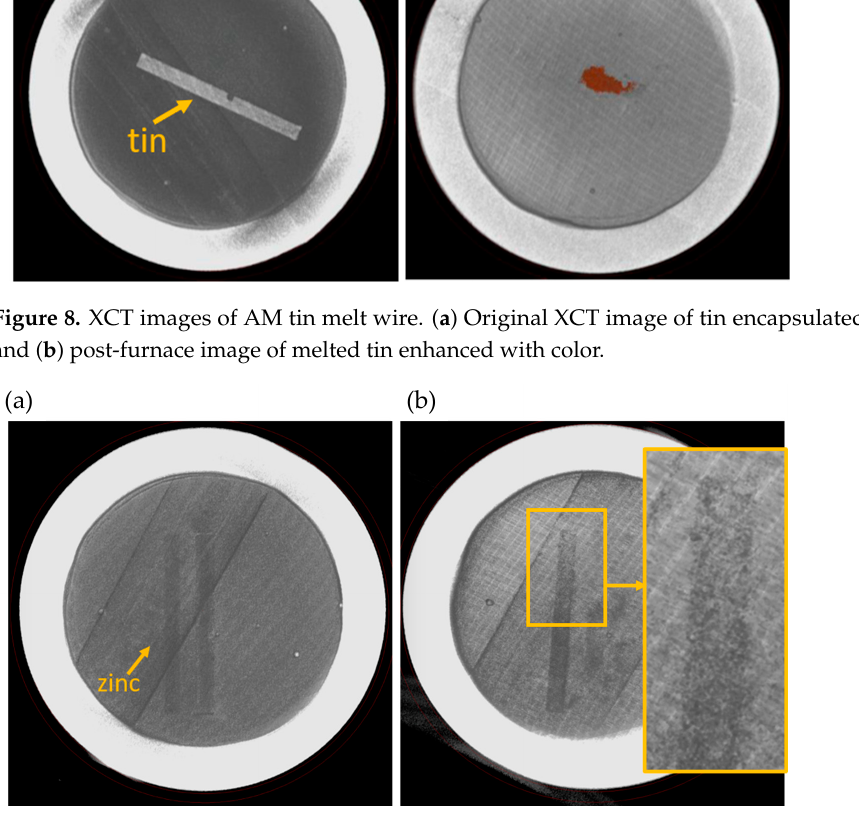
Figure 9. XCT images of AM zinc melt wire. ( a ) Original XCT image of zinc encapsulated in helium, ( b ) post-furnace image of zinc with enhanced image highlighting material separation.